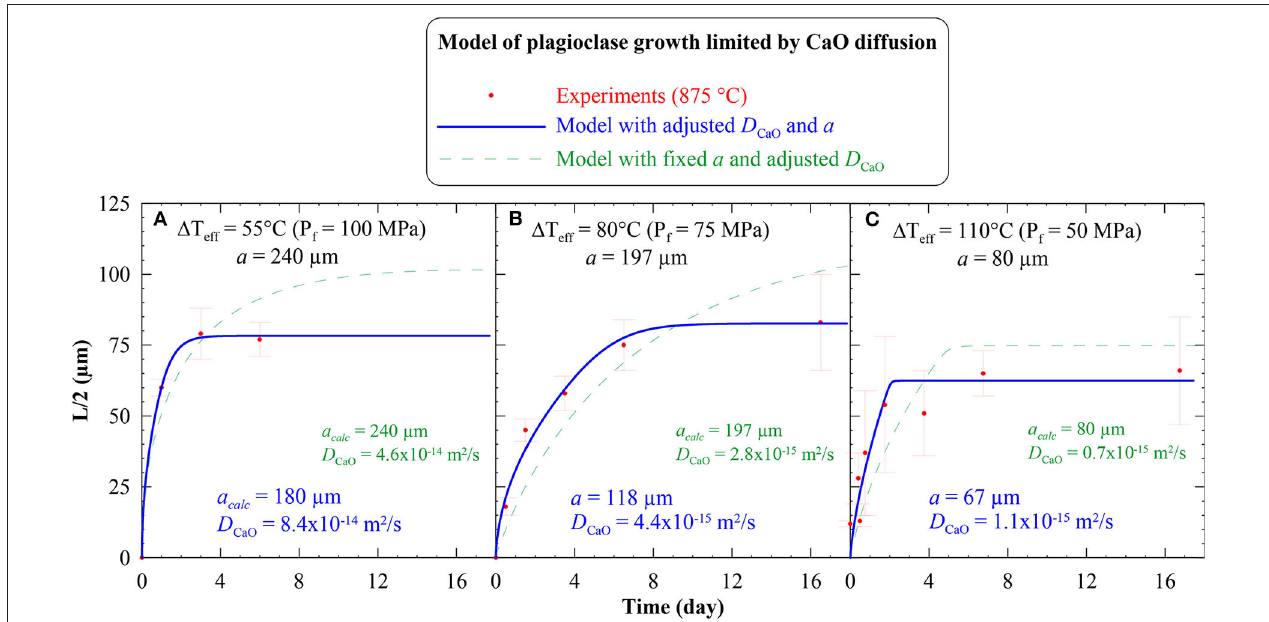
FIGURE 4 | Time evolution of the plagioclase crystal size (half-length of the ten longest long-axes; L /2) for a growth limited by the diffusion of CaO ( D CaO ), following Fick’s diffusion equations considering a time-advancing crystal-melt interface in a finite reservoir. (A) 1 T eff = 55 ◦ C; (B) 1 T eff = 80 ◦ C, and (C) 1 T eff = 110 ◦ C a gives the characteristic length of the system determined from the experimental samples, as given in Table 3 . The red dots represent the experimental data, as given in Figure 1C . The plain blue curves show the results for the model adjusting both, the characteristic length of the system ( a calc ) and D CaO , in order to best fit the experimental data. The dashed green lines show the results for the model adjusting D CaO with a fixed to the experimental value.